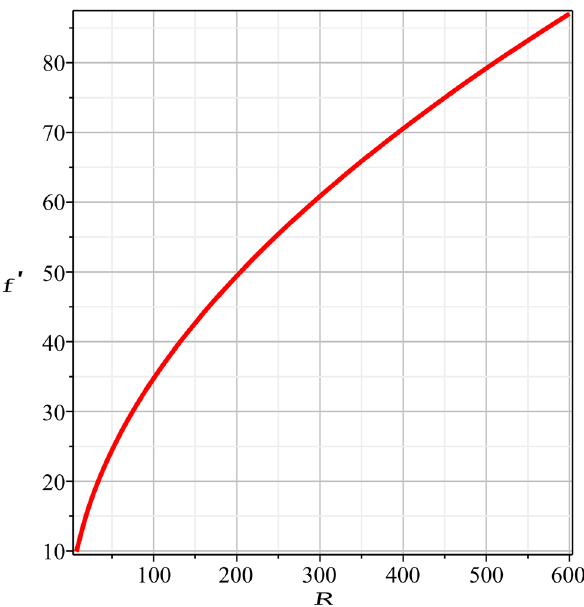
Fig. 4 This figure demonstrates the plot of f (cid:5) ( R ) (obtained from numerical analysis) versus curvature R at curvature interval [ 7 , 600 ]